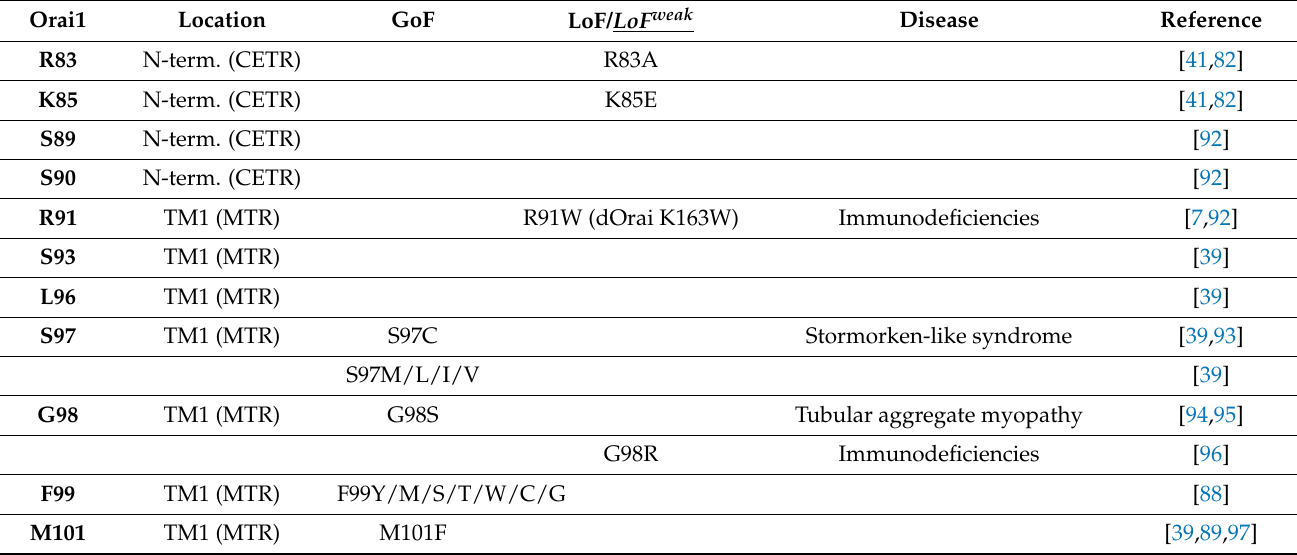
Figure 4. Important gating checkpoints. ( A ) The scheme highlights the location of the MTR region (cyan) ( top left , A ). The Orai1 subunit depicts the residues within the TM1–TM2/TM3 hydrophobic cluster ( top right , A ). The Orai1 monomer displays positions of the residues within the MTR that lead to GoF upon the single-point mutation ( bottom left , A ). Residues that mediate the TM3–TM4 interaction are visualized ( bottom right , A ). ( B ) The scheme highlighting the location of the CETR region (green) ( top middle , B ). The Orai1 monomer depicts the residues responsible for the communication between the Orai1 N-terminus and loop2 ( bottom left , B ). Orai1 results in the constitutively active channel upon fourfold mutation of the C-terminal kink at 261LVSHK265 to 261ANSGA265 and single-point mutation of the TM4 kink at P245 to any other amino acid, suggesting that these regions mediate the closed state of the channel ( bottom right , B ). ( C ) The Orai1 top view highlights the TM2/TM3 ring which spans from MTR to CETR. The monomer displays the crucial gating checkpoint residues of the TM2/TM3 ring. The serine ridge seems to provide flexibility within the conformation of the inner pore and is assumed to be responsible for the communication with the polar surfaces of TM2/TM3 ring ( bottom middle , C ). With respect to the entire library of known Orai1 mutations (Figure 3 and Table 1), remarkably, all so far identified GoF mutants are widely located within the central seg- Table 1. Crucial Orai1 gating checkpoints. Summary of residues in Orai1 functioning as crucial gating checkpoints together ments of the TM regions and in a helical segment of TM4 close to the extracellular side, with their location within Orai1, known gain- (GoF) and loss-of-function (LoF) mutations at the respective positions, and their relevance in disease (N-term., N-terminus; C-term., C-terminus). Orai1 Location GoF LoF/ LoF weak Disease Reference